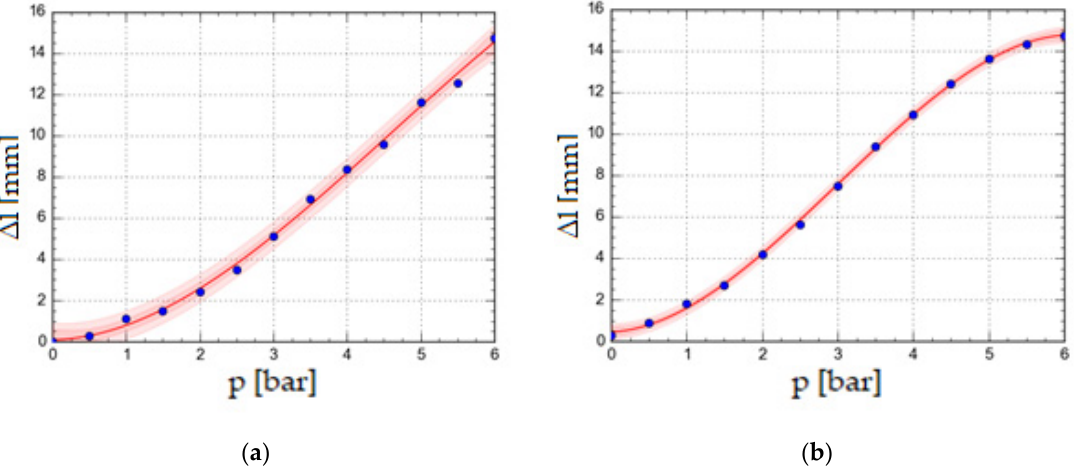
Figure 8. Polynomial regression. ( a ) Inflation; ( b ) deflation. For both regressions, the correlation coefficients ( r inflation = 0.998, r deflation = 0.999) and the coefficients of determination ( r 2 inflation = 0.997, r 2 deflation = 0.999) validate the functions developed in Equations (3) and